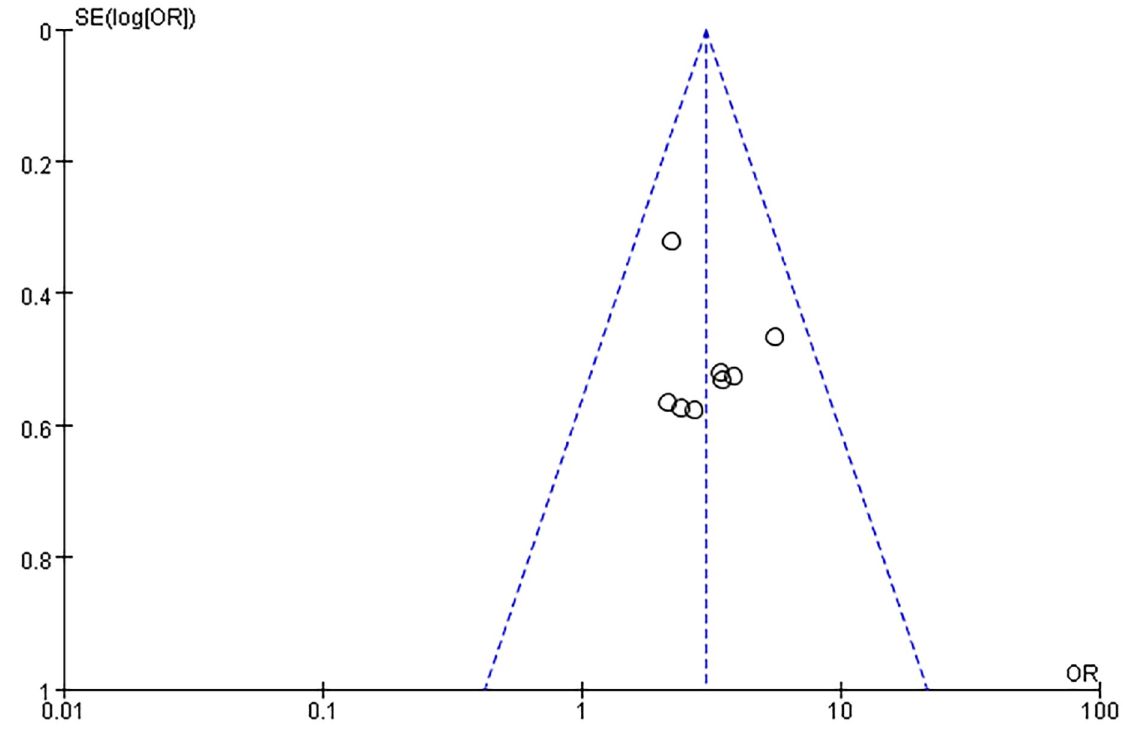
Fig 3. Inverted funnel plot investigating publication